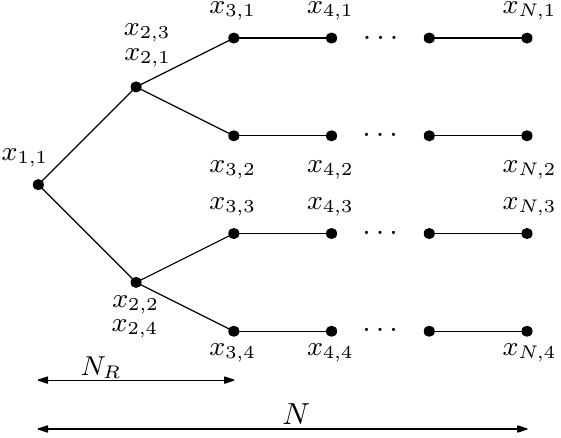
Figure 3. Scenario tree representation of the uncertainty evolution with two models ( M = 2) and a robust horizon of two samples ( N R = 2). The notation x k , j represents the state x at sample k for j th